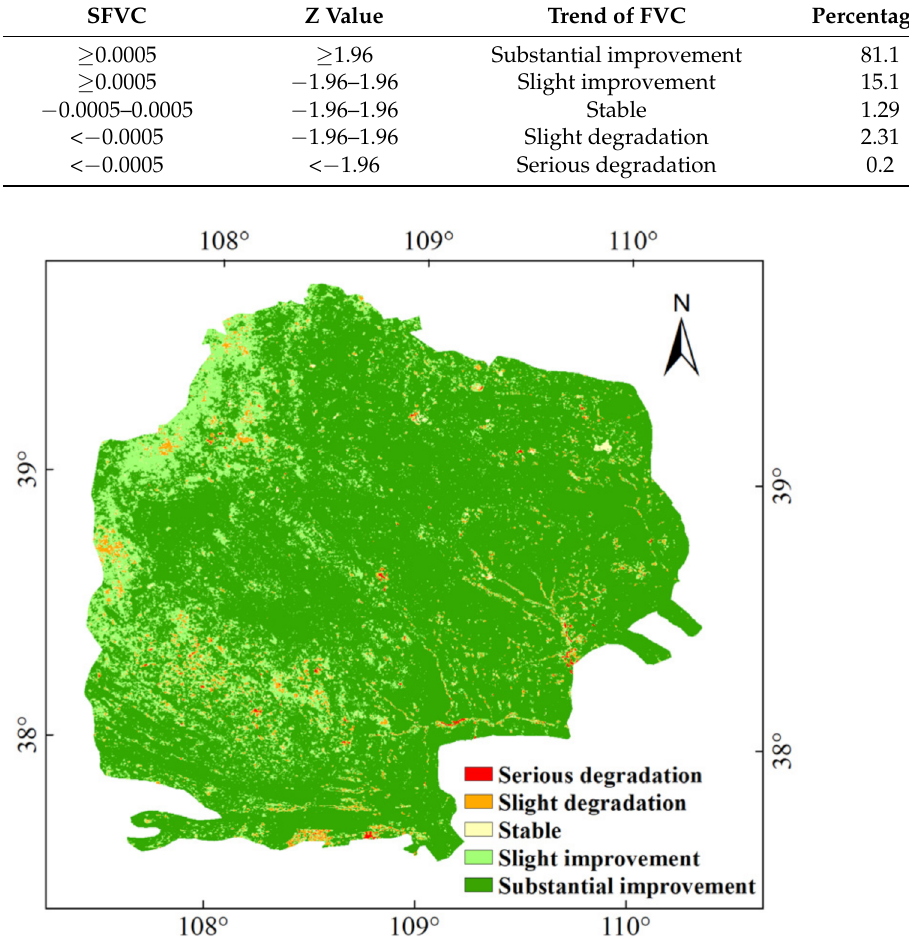
Table 2. Statistics of vegetation change trends in the past 20 years.